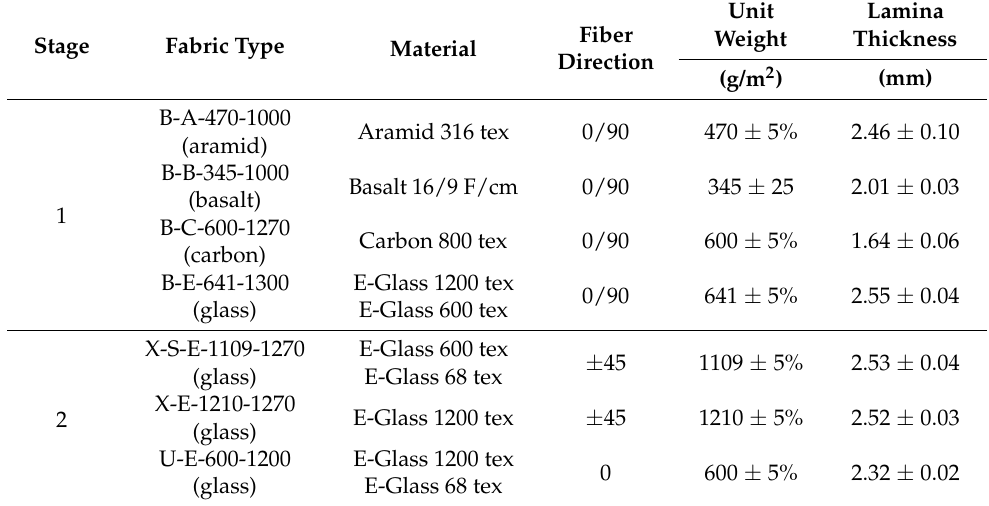
Table 1. Details of fabrics used in the first and second stages of the research.